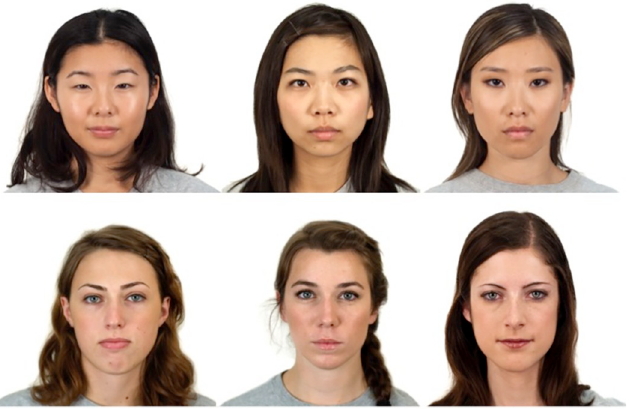
Fig 1. Visual stimuli. Photographs of women of Asian ethnicity and white European ethnicity used in both the rating and sentence repetition tasks.